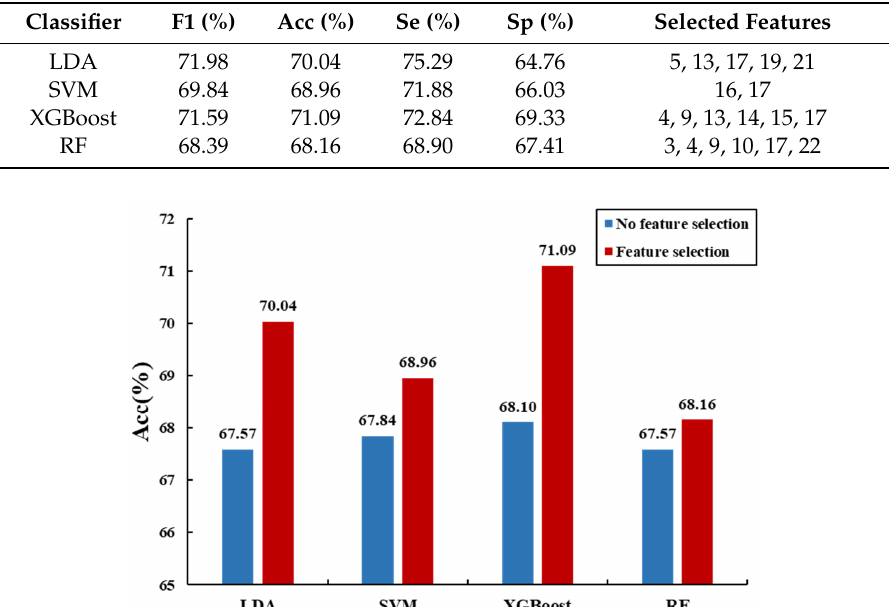
Table 3. Comparison of performance of di ff erent classifiers with feature selection.